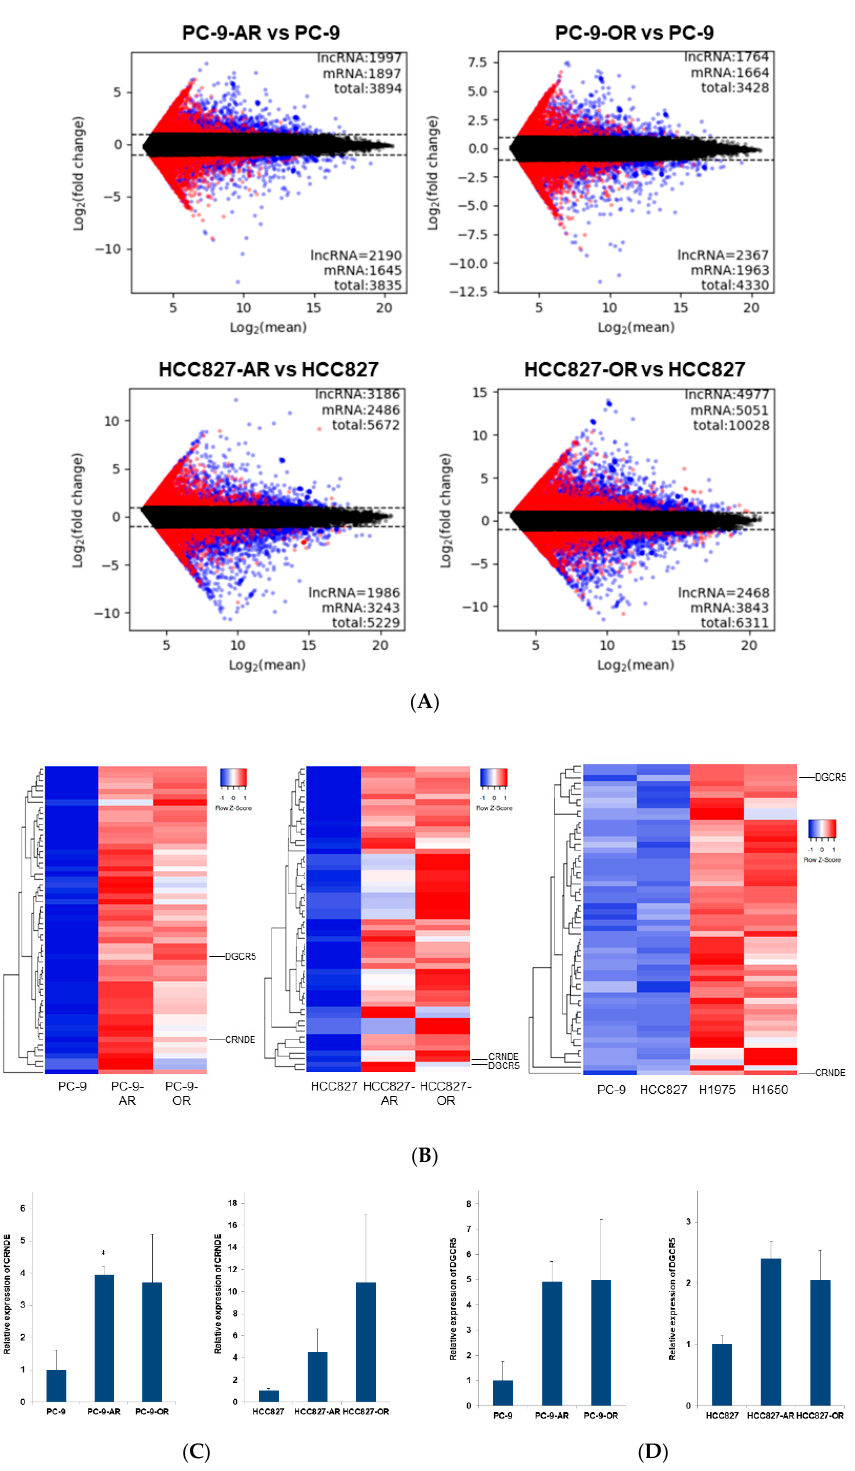
Figure 2. Overexpression of CRNDE and DGCR5 in EGFR-TKIs-resistant NSCLC cells. ( A ) Microarray analyses: The candidate lncRNAs (blue) and mRNAs (red) were determined by differences in expression using a cut-off value of more than two-fold change between resistant and parental cells. ( B ) The expression of CRNDE and DGCR5 lncRNAs was higher in all examined resistant cell lines than in the parental cell lines. In addition, these lncRNAs showed higher expression levels in intrinsic afatinib or osimertinib-resistant cells (i.e., H1975 and H1650) than in sensitive cells (i.e., PC9 and HCC827). ( C ) The expression of CRNDE was higher in all examined resistant cell lines than in the parental cell lines. * p < 0.01. ( D ) The expression of DGCR5 was higher in all examined resistant cell lines than in the parental cell